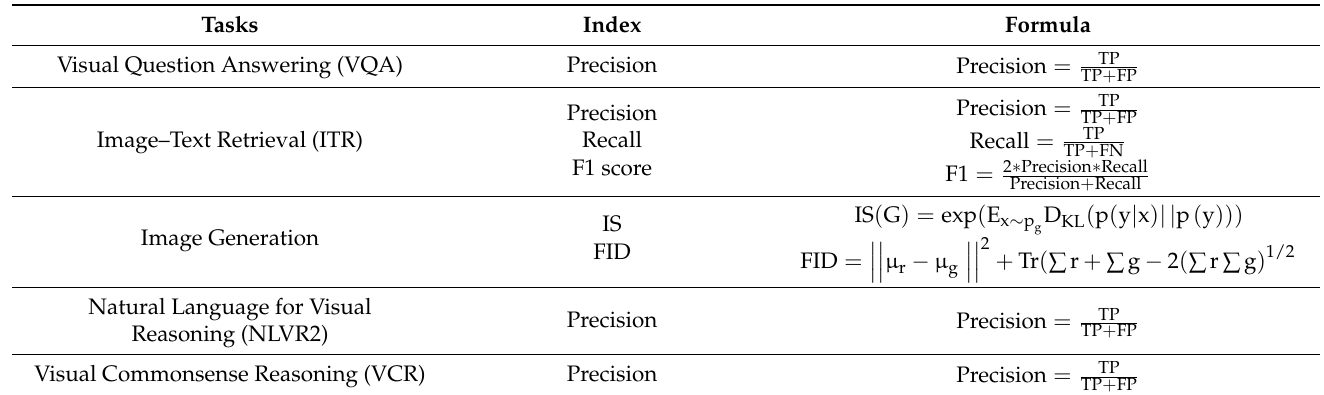
Table 1. Some vision–language tasks and evaluation indicators.